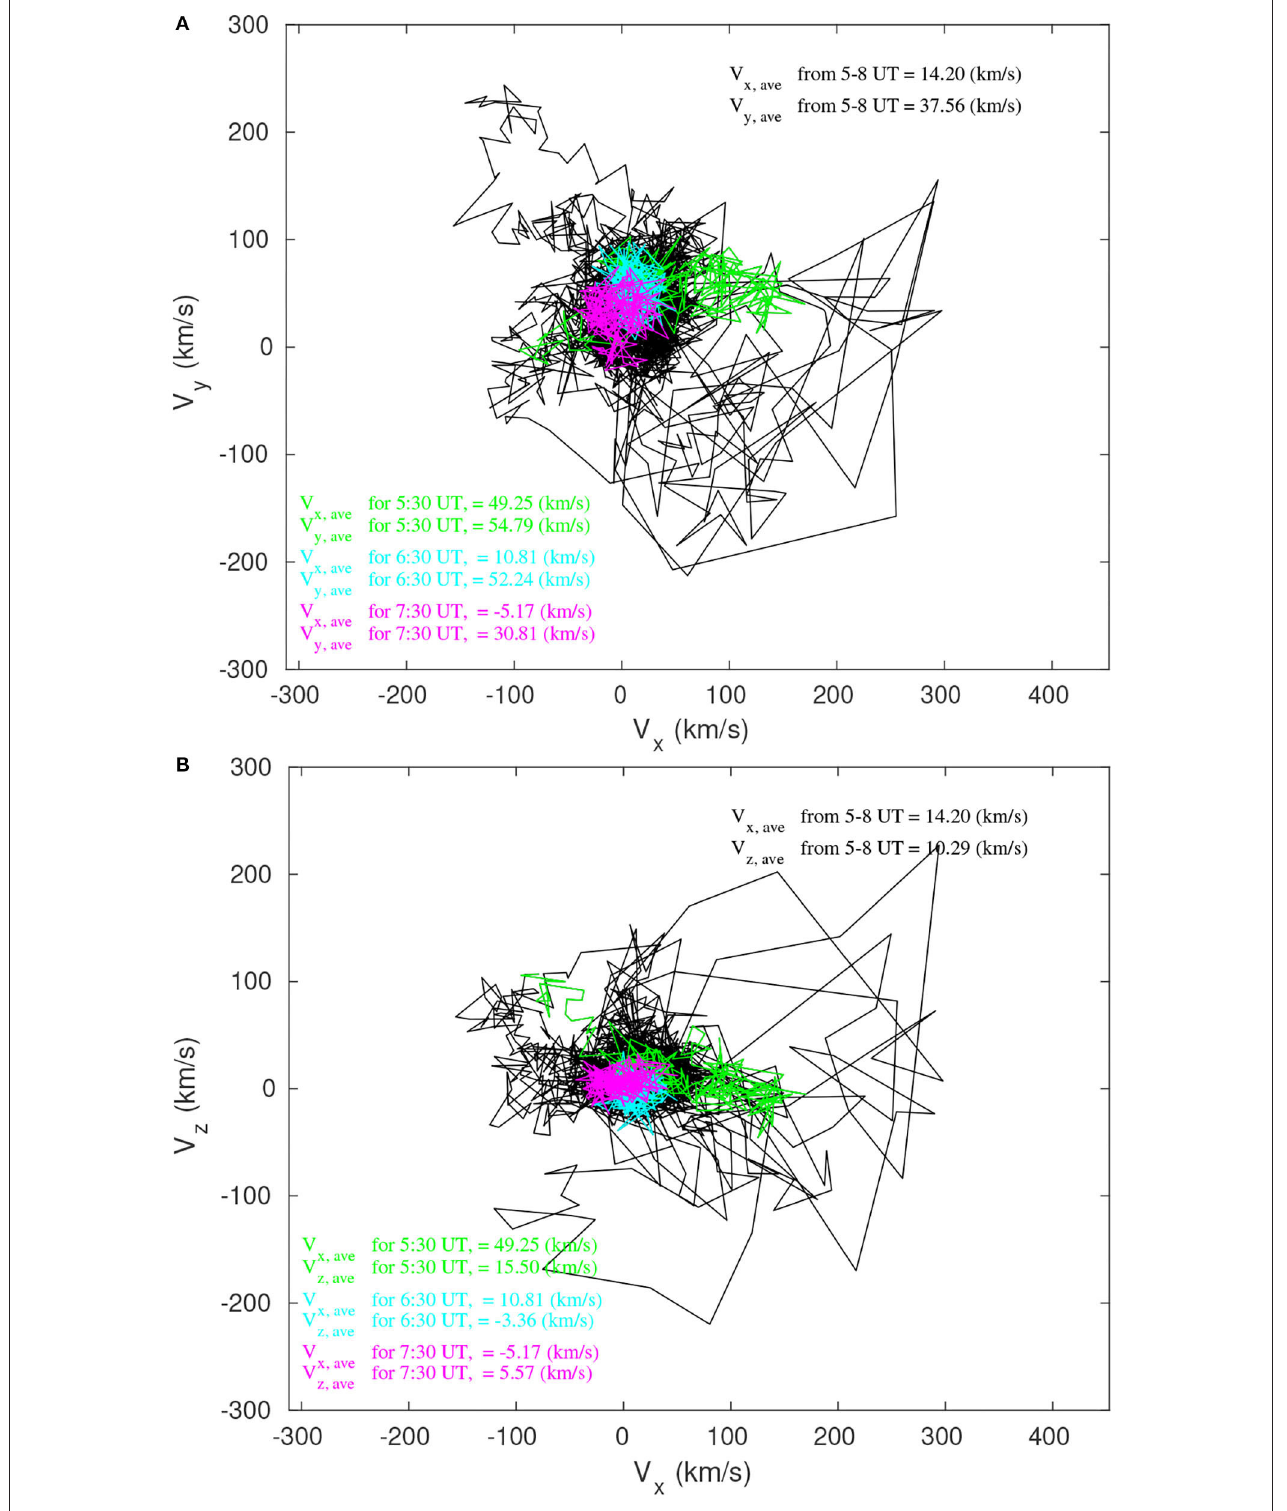
FIGURE 3 | Hodograms of flow measured between 5 and 8 UT by THEMIS-C (THC) on 26 February 2008 and during three 12 min intervals. Panels from top to bottom are: (A) V x and V y , (B) V x and V z bulk velocity components. The colors represent 12 min intervals centered at the time indicated in the lower left corner by the same color together with the average bulk velocity calculated for each